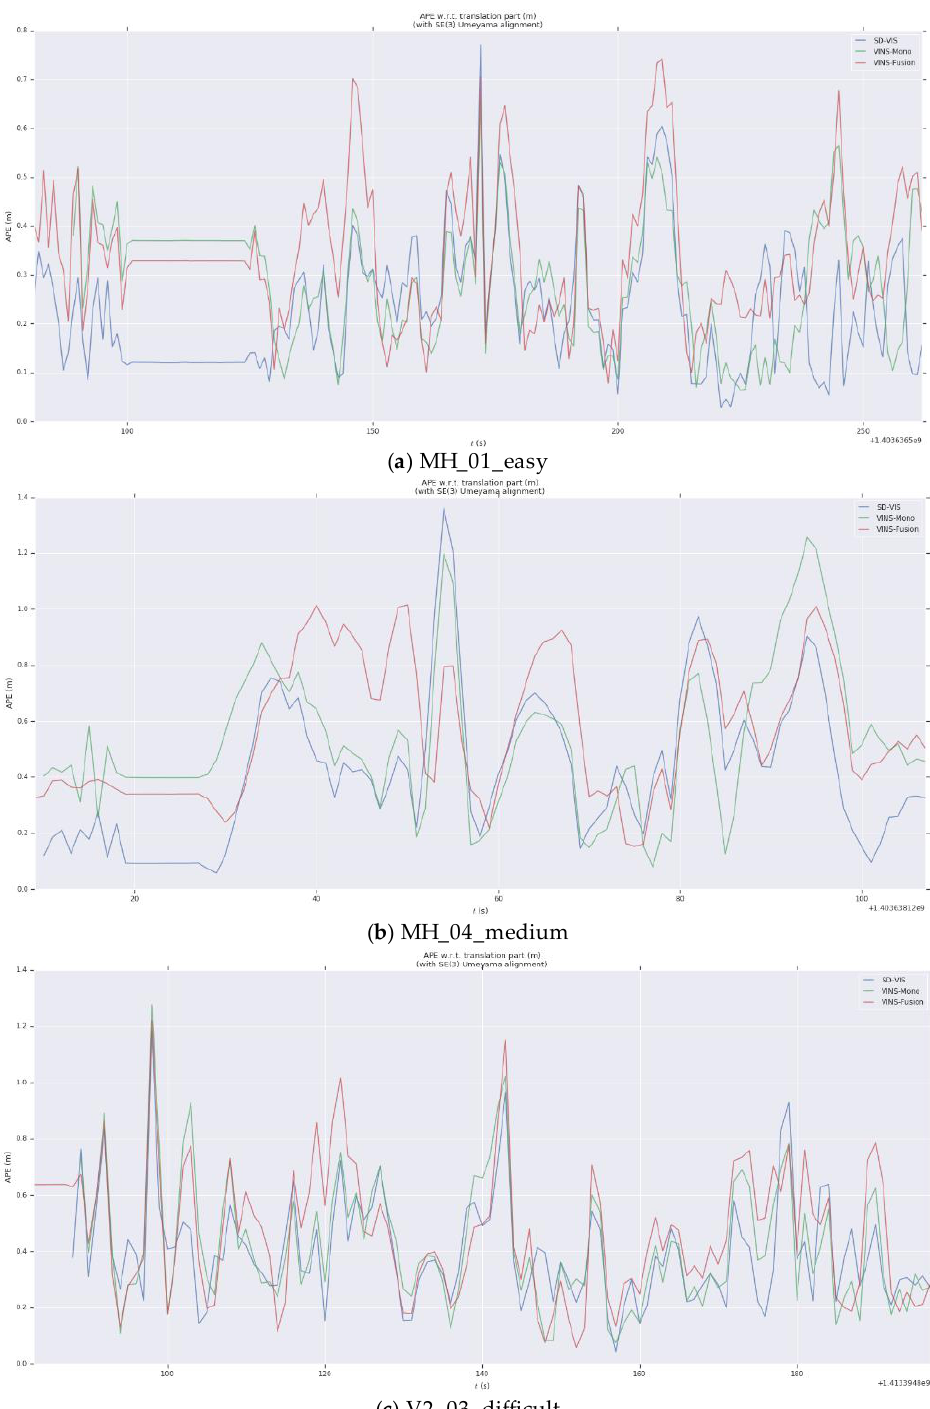
Figure 8. The change of translation absolute pose error with time in MH_01_easy, MH_04_medium and V2_03_difficult. Blue, green, and red represent SD-VIS, VINS-Mono, and VINS-Fusion respectively